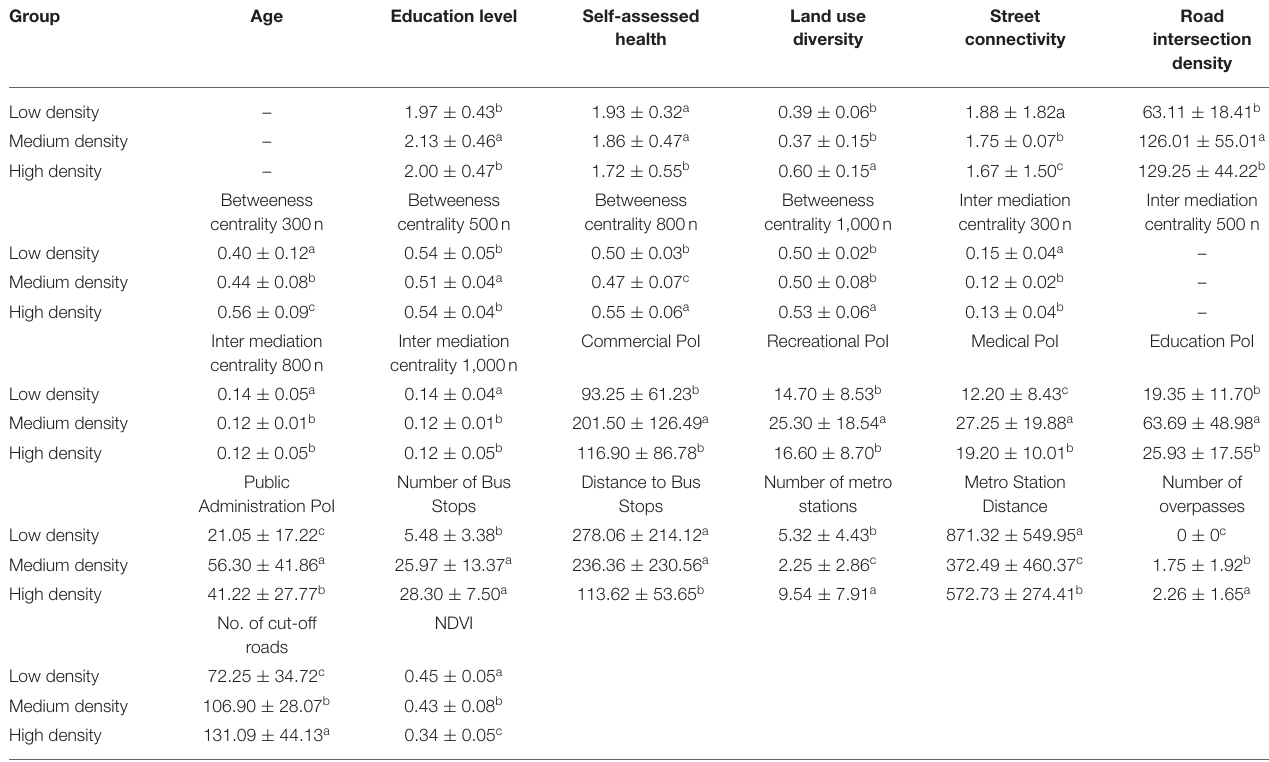
TABLE 2 | Tests for differences between groups in the low, medium, and high-density subgroups.